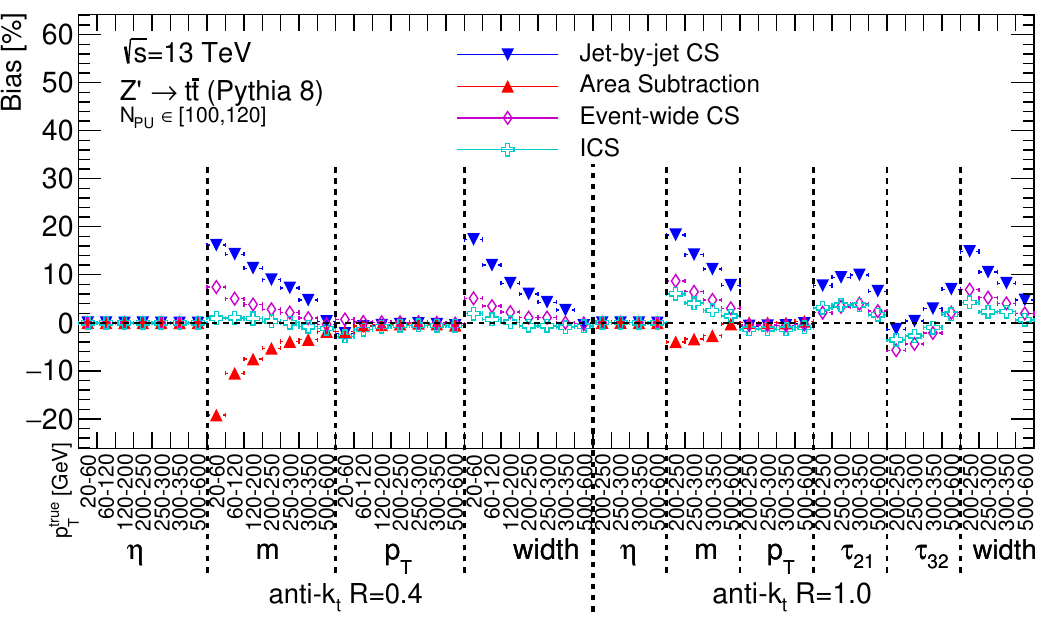
Figure 4. Performance of the pileup subtraction evaluated in terms of the bias for di(cid:11)erent observables: jet (cid:17) , mass, p T , width for R = 0 : 4 jets and jet (cid:17) , mass, p T , width, (cid:28) 21 , (cid:28) 23 for R = 1 : 0 jets. Each bin on the x -axis represents a given range of true jet p true de(cid:12)ned by the bin-label. Bins T on the x -axis are grouped to distinguish observables and jet radii. Four algorithms are compared: Jet-by-jet CS, Area Subtraction, Event-wide CS, and ICS